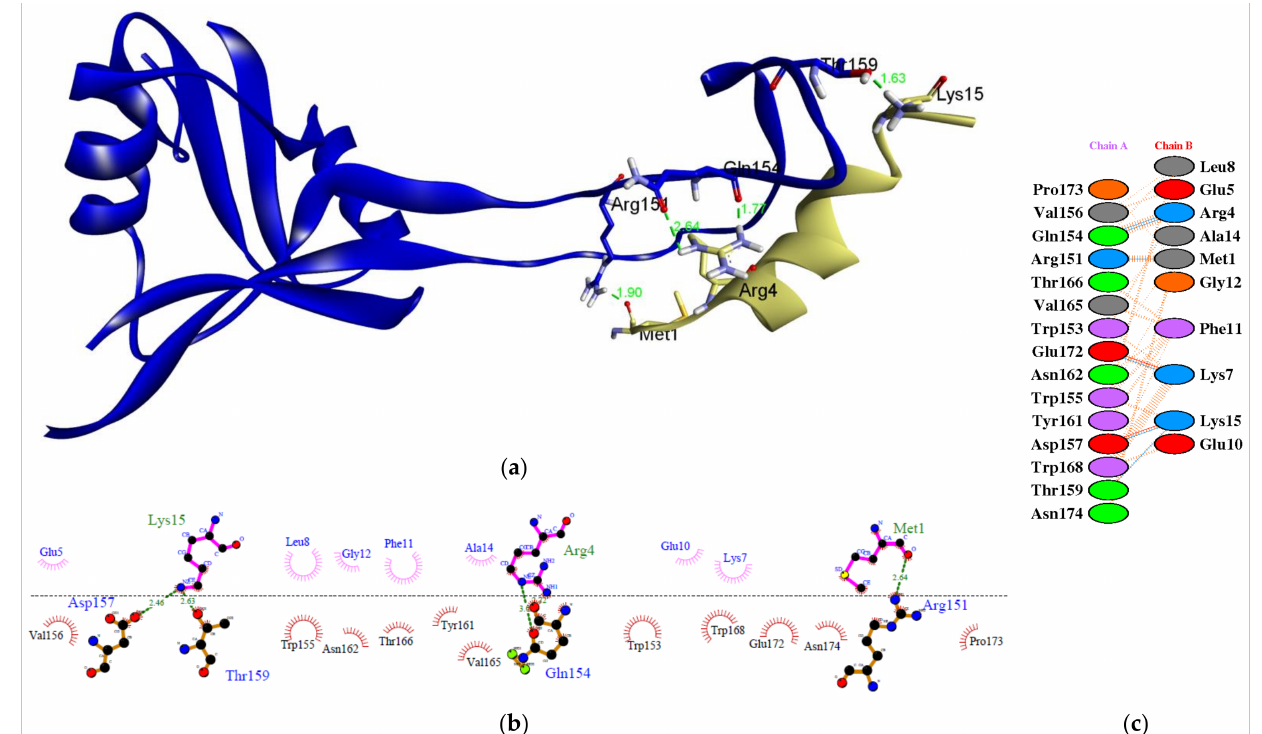
Figure 3. The molecular docking between the epitope MGKREKKLGEFGKAKG and paratope in the dendritic cells: ( a ) three-dimensional (3D) visualization showing that epitope binds in the pocket site of paratope; ( b ) two-dimensional (2D) visualization of the interaction of the complex using LigPlot+ V.2.2; ( c ) 2D visualization of the interaction generated from PDBSum webserver. The epitope is indicated in green color and the paratope is indicated in blue